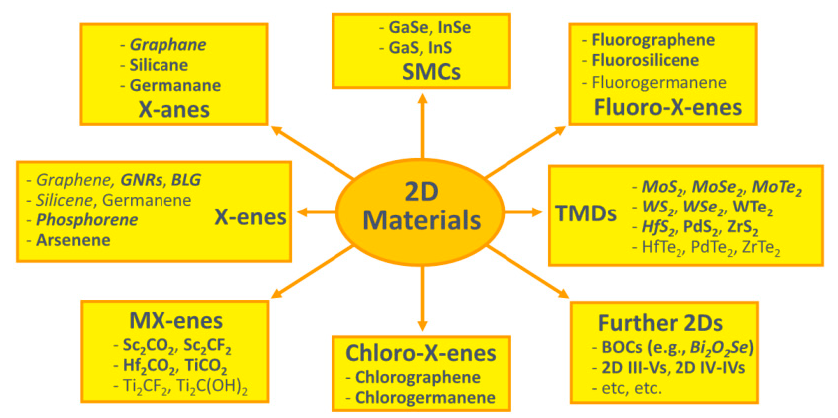
Figure 58. Drawing of different 2D materials [385].